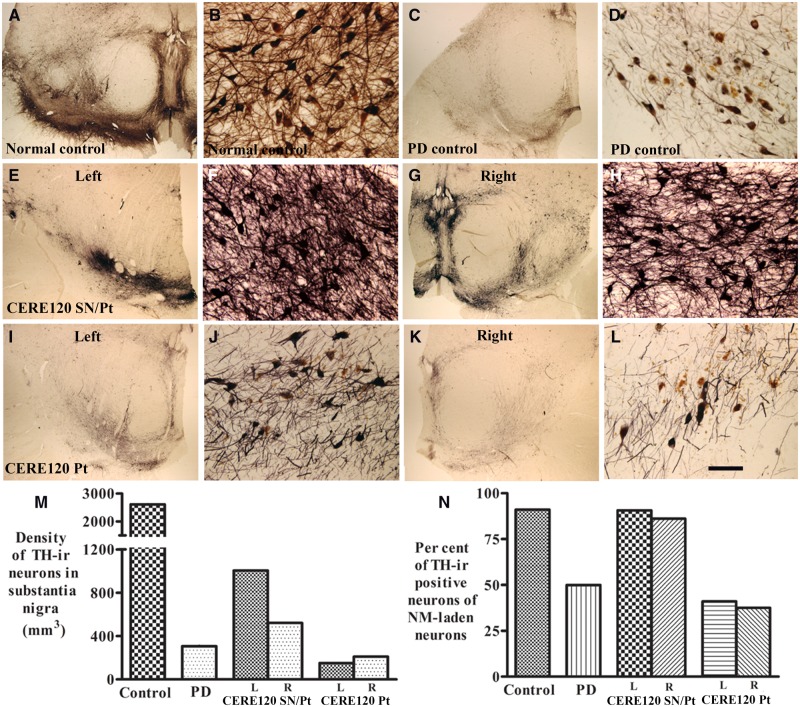

Qualitative and quantitative evaluation for TH expression in substantia nigra with or without CERE120 delivery. Sections from substantia nigra show TH-immunoreactive patterns in age-matched control (A and B), Parkinson’s disease without gene delivery (C and D), Parkinson’s disease with combined nigral and putamenal CERE120 delivery (CERE120 SN/Pt; left nigra: E and F; right nigra: G and H), and Parkinson’s disease with putamenal CERE120 delivery only (CERE120 Pt; left nigra: I and J; right nigra: K and L). Note that enhanced TH-staining neurons were observed in the nigral regions with CERE120 (E–H) but not in the nigral regions without CERE120 (I–L). Scale bar in L = 100 µm for B, D, F, H, G and J and 1.6 mm for A, C, E, G, I and K. Stereological analyses revealed that the density of TH-positive neurons was higher in Parkinson’s disease with combined nigral and putamenal CERE120 delivery(CERE120 SN/Pt), than Parkinson’s disease with putamenal CERE120 delivery only (CERE120 Pt). (N) The majority of remaining melanized neurons were TH-positive in Parkinson’s disease with combined nigral and putamenal CERE120 delivery (CERE120 SN/Pt) relative to Parkinson’s disease with putamenal CERE120 delivery. PD = Parkinson’s disease; ir = immunoreactivity.